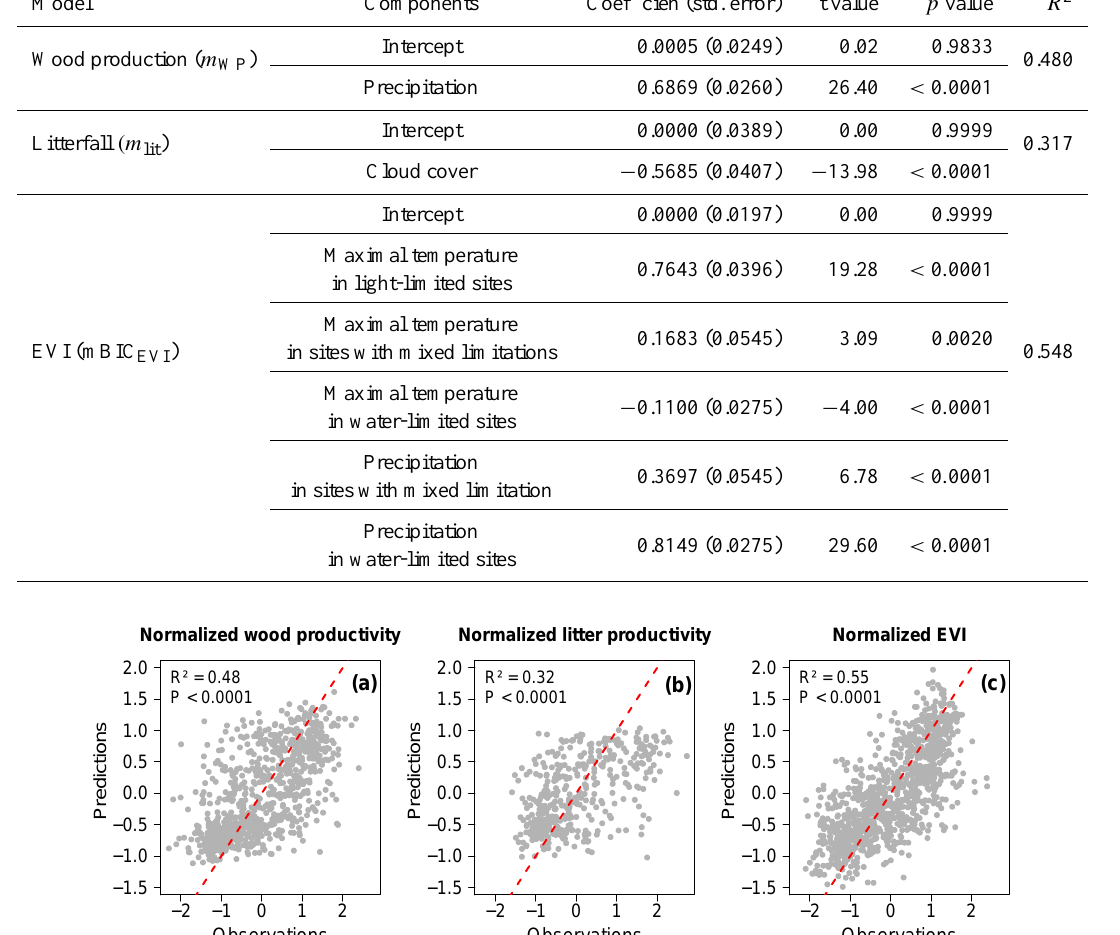
Table 4. Intercepts and slopes of the fitted linear models for seasonal wood production ( m WP ), litterfall ( m lit ) and EVI (mBIC EVI ); with the seasonal climate variables: precipitation (pre), cloud cover (cld) and maximal temperature (tmx). Light-, water- and mixed limitation indicate the limitation of the sites and are defined with the value of (cid:49) EVI wet-dry (Fig. 6 for the definition of the thresholds).